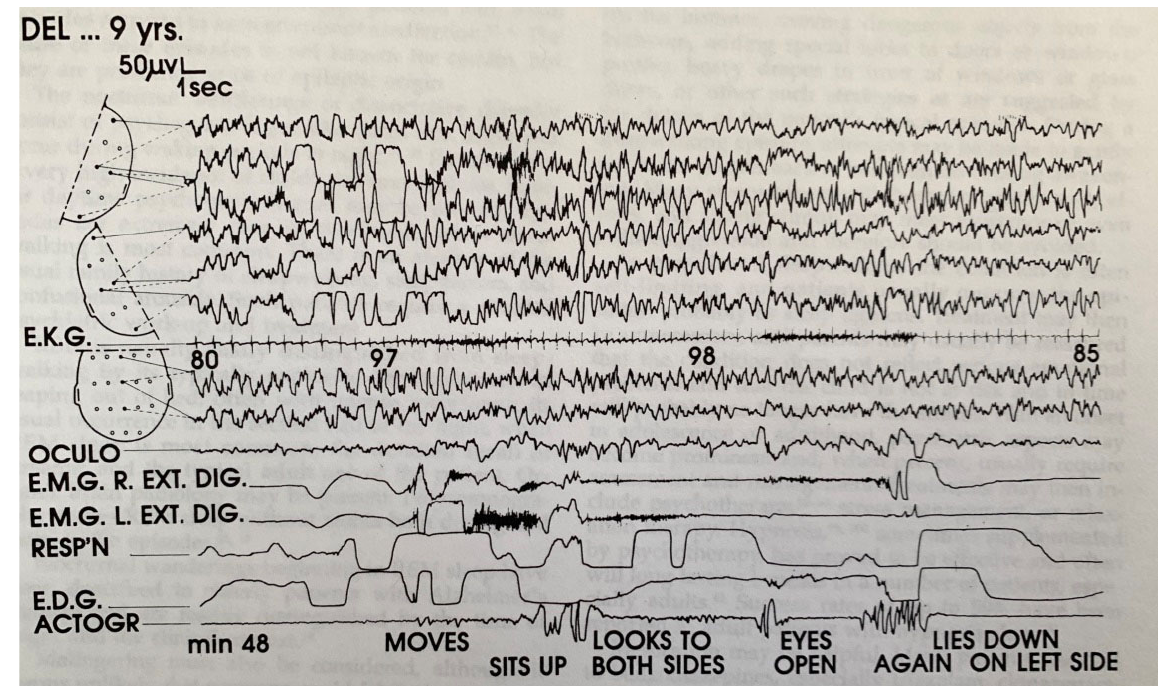
Figure 7. An episode of sitting up and looking around in a 9-year old chronic sleepwalking girl who moves, then sits up, looks around the room with eyes open and lies down again. The EEG shows continual sleep throughout the behavioral event. (Adapted from Gastaut, H. and Broughton, R.: A clinical and polygraphic study of episodic phenomena during sleep. Academic Address, in: Wortis, J. (Ed.), Recent Advances in Biological Psychiatry, New York, Plenum Press, 1965, pp. 197–221).